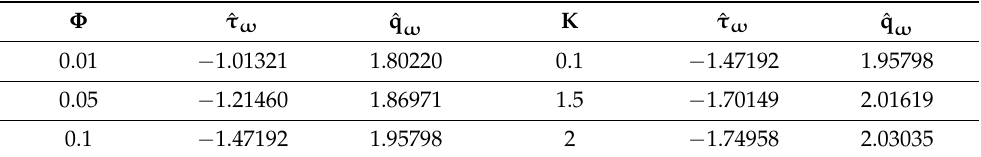
Table 3. Shear stress and heat flux for nanoparticles volume fraction Φ and material parameter